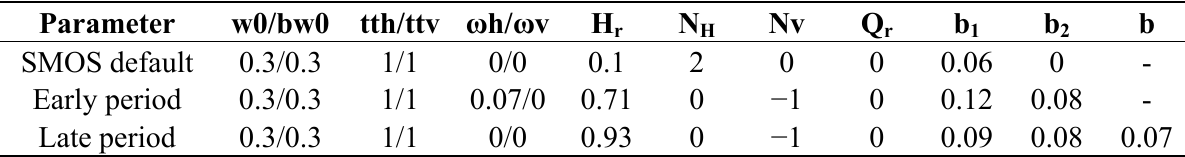
Table 3. The different parameterizations used for L-band microwave emission of the biosphere (L-MEB) in this study. The first one corresponds to the Soil Moisture and Ocean Salinity (SMOS) default parameterization for Central European Crops, the other two have been developed within this study for the period before (early period) and after winter (late